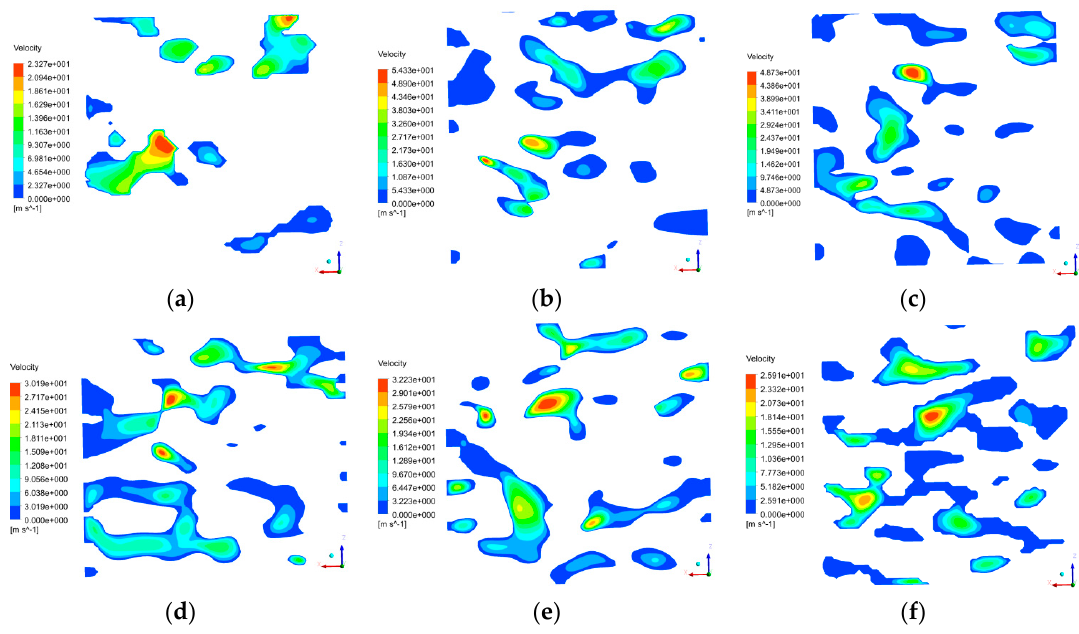
Figure 13. Water seepage velocity distribution of different sections of the single channel in the Y direction: ( a ) x = 0 µ m; ( b ) x = 12 µ m; ( c ) x = 24 µ m; ( d ) x = 36 µ m; ( e ) x = 48 µ m; and ( f ) x = 60 µ m.